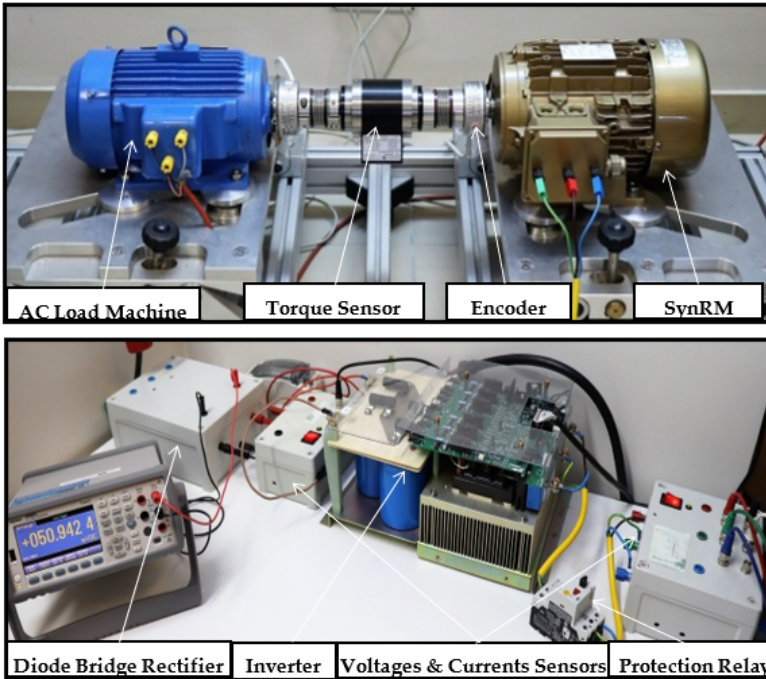
Figure 4. Experimental Setup. Table 1. Parameters Of The Used 2.2 Kw SynRM.